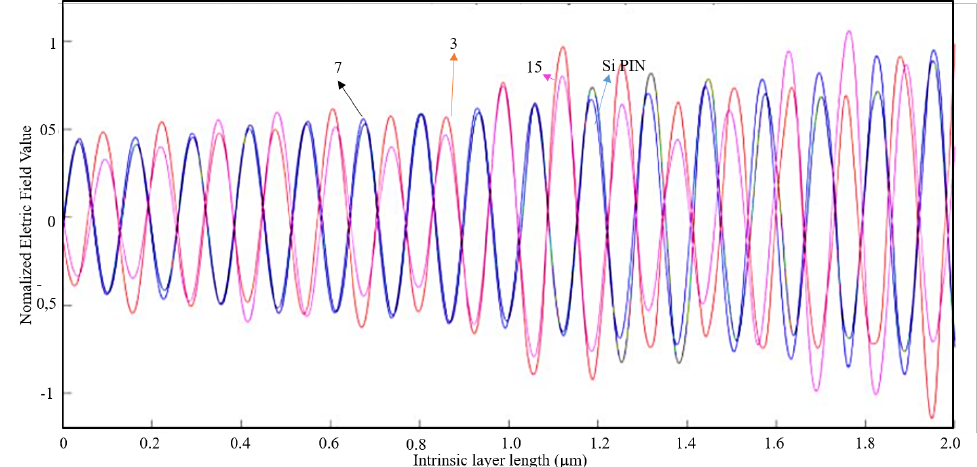
Figure 15. 1D Plot of the normalized electric field, z-component, along the intrinsic zone for a light wavelength of 530 nm: Si PIN junction (blue); 3-slit array Al nanoantenna (red); 7-slit array Al nanoantenna (black); and 15-slit array Al nanoantenna